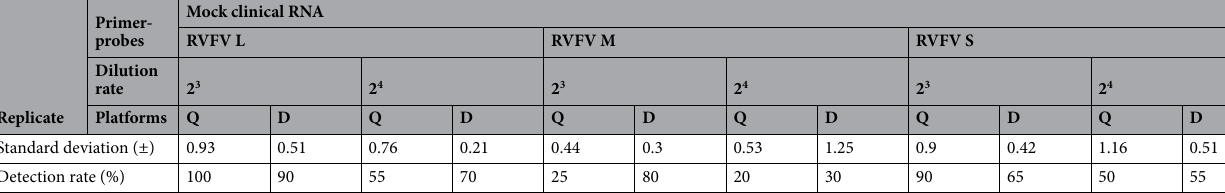
Table 4. Comparison of each segment assay on both the RT-qPCR and RT-ddPCR platforms. Analyses of the diluted (2 3 and 2 4 ) cultured and mock clinical RNAs were performed in 20 replicates. The ‘U’